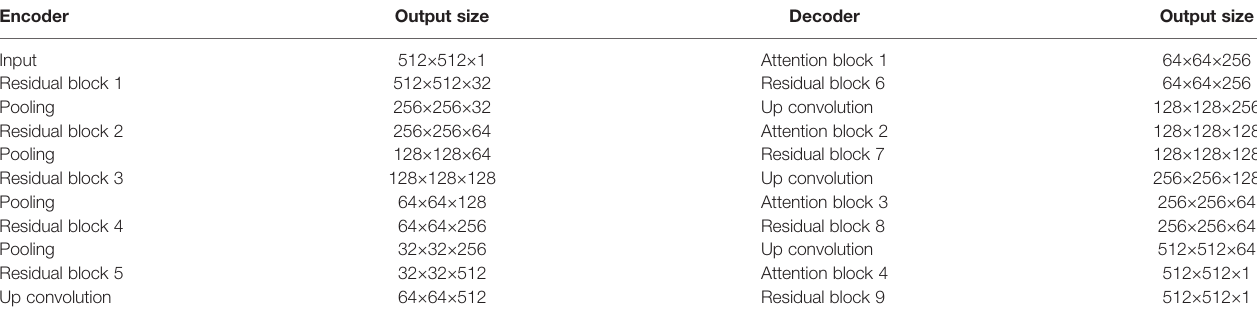
FIGURE 1 | Architecture of residual attention U-net (RA-Unet). TABLE 2 | Architecture of the 2D RA-Unet used for liver